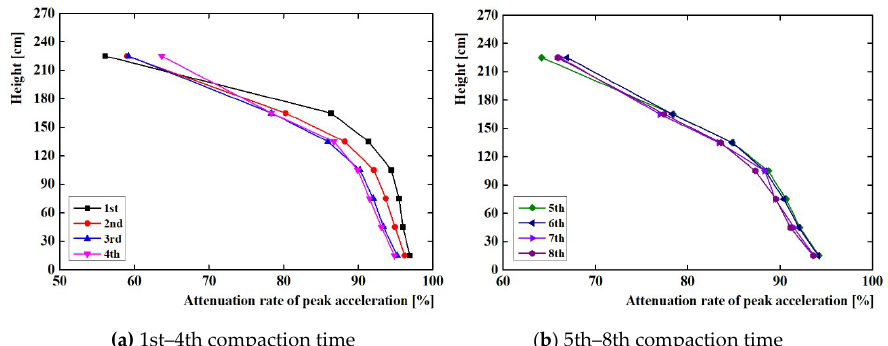
Figure 6. Peak acceleration of each measuring point.